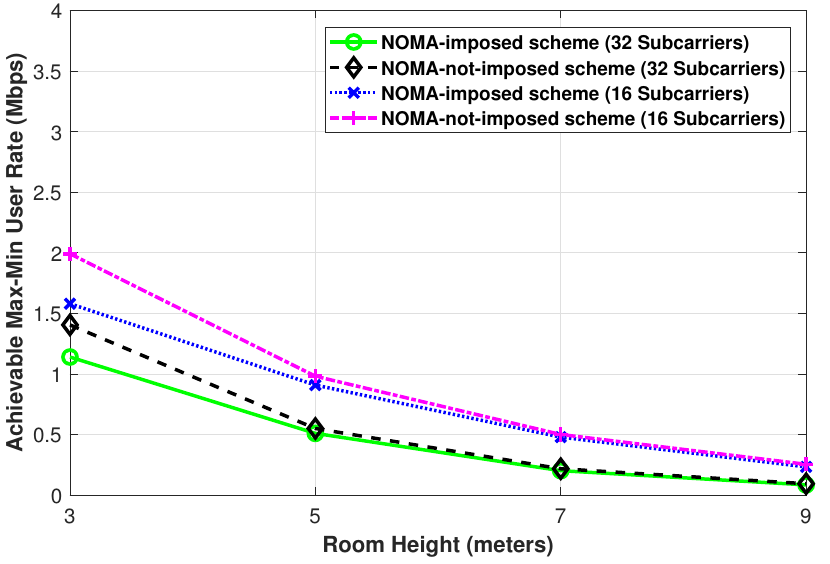
Figure 10. The achievable max-min user rate of the NOMA-imposed scheme and the NOMA-not- imposed scheme obtained while changing the room height. ( P e = 35 dBm, L = 4, N = 20, φ 1/2 = 60 ◦ , Ψ = 85 ◦ 1/2